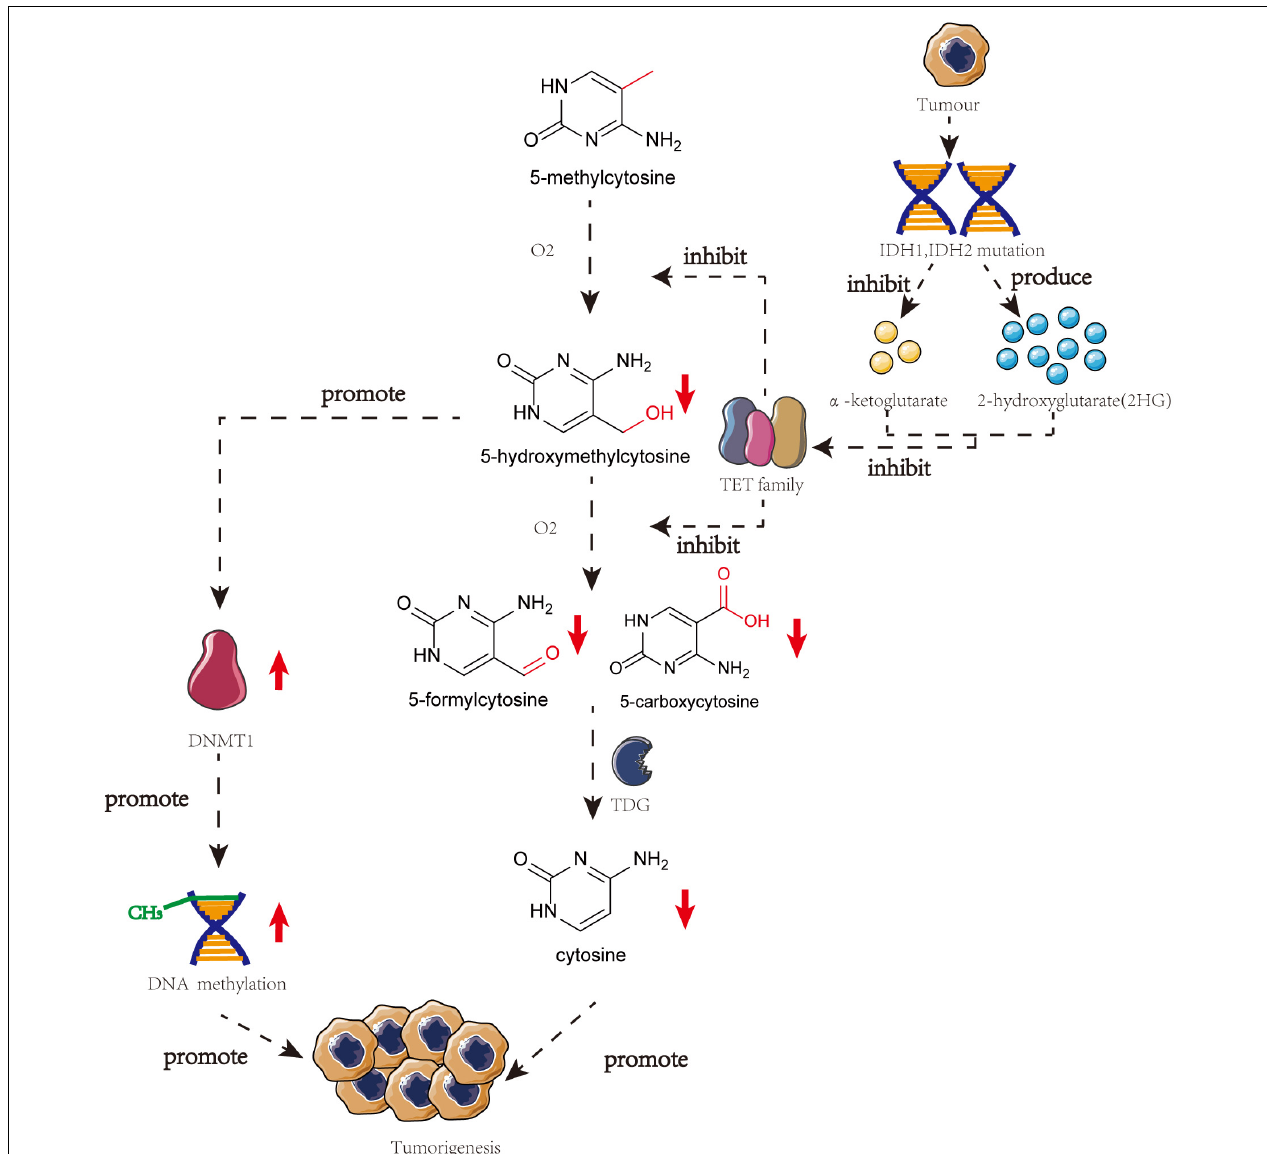
FIGURE 2 | The crosstalk of DNA methylation and DNA hydroxymethylation in the progress of the tumor. In many different kinds of cancers, IDH1, and IDH2 will mutate which can restrain the production of α -ketoglutarate and produce 2HG. Both of these two phenomena will lead to the inhibition of TET family and meanwhile, the low level of 5-hmC can promote the activity of DNMT1. These two pathways will finally result in the